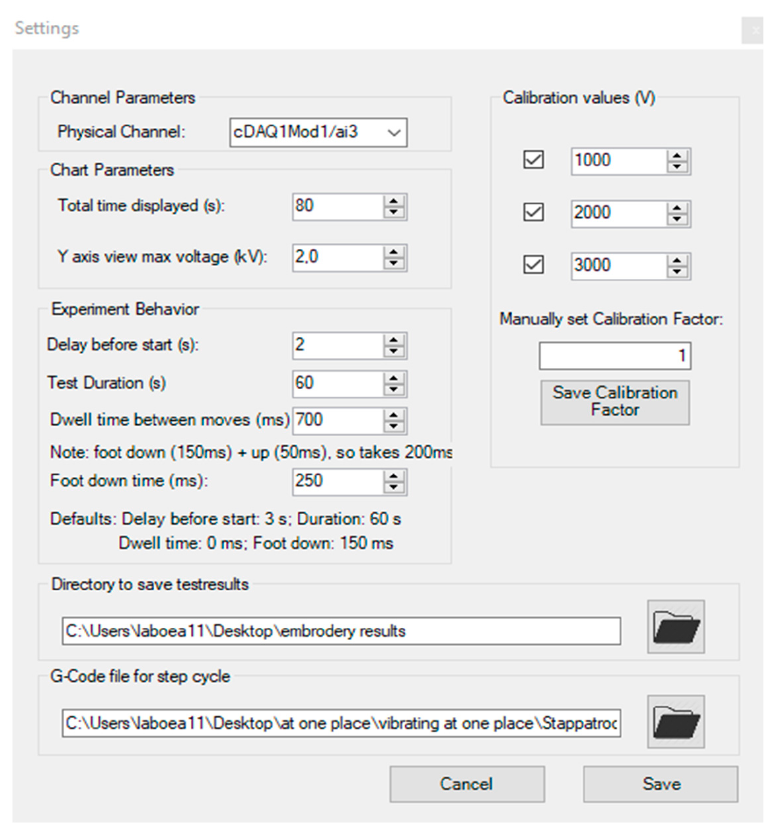
Figure 3. The GUI (Graphical User Interface) shows the control of total test time, 1 hertz frequency with help of Dwell Time (700 ms) + Foot Up Time (50 ms) + Foot Down Time (250 ms).